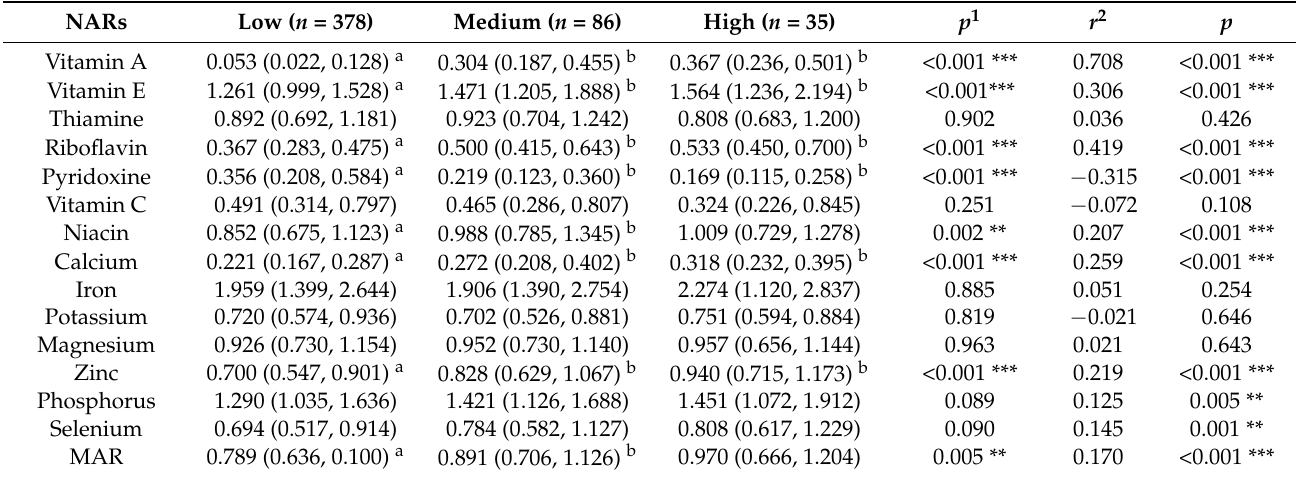
Table 5. Nutrient adequacy ratio of specific nutrients by DDS groups ( N = 499).